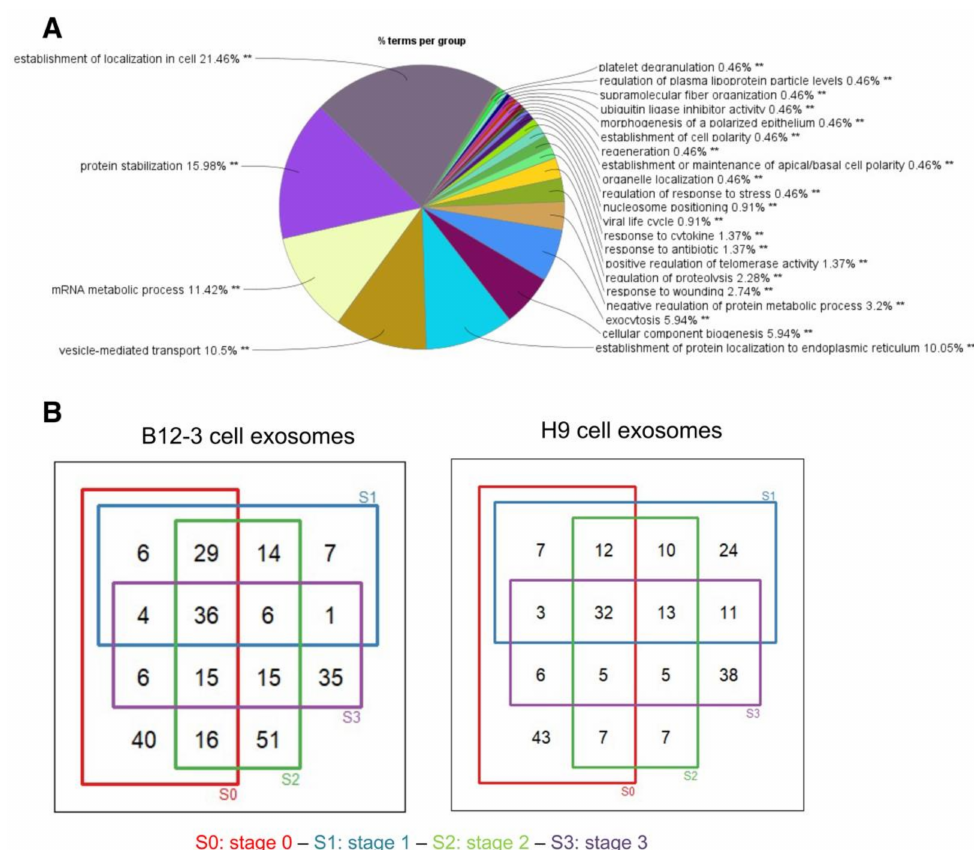
Figure 3. Gene ontology (GO) and quantification of the number of proteins shared among exosomes harvested from various stages of cardiogenic differentiation. ( A ) GO analysis of all proteins found in exosomes from H9 and B12-3 hPSCs coaxed toward CMs. ( B ) Venn diagrams of exosomal proteins at different stages (S0 to S3) of the cardiogenic commitment of B12-3 and H9